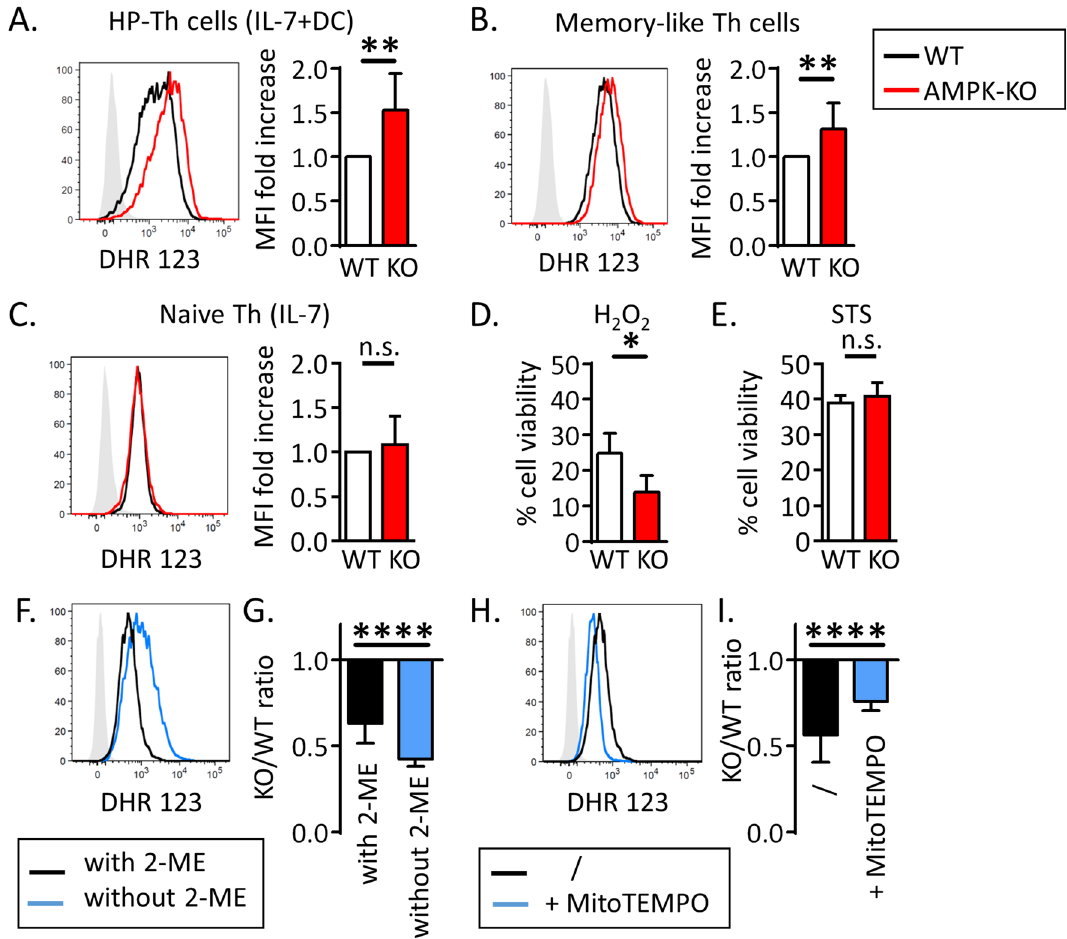
Figure 6. AMPK dampens ROS production and toxicity in T cells. ( A – C ) Cellular ROS staining with DHR123 probe in IL-7 + DC-expanded T cells ( A ), in memory-like Th1 cells ( B ), and in naive T cells ( C ). FACS staining of a representative experiments (left panels) and histogram showing MFI fold increase in AMPK-KO cells in comparison to WT cells set to 1 (right panels). ( D , E ) Percentages of cell viability after treatement of WT and AMPK-KO naive Th cells with H 2 O 2 (0.5 mM for 2 h, D ) or with staurosporine (STS, 5 µM for 4 h, E ). ( F , H ) Cellular ROS staining of naive Th cells after 4 days in IL-7-supplemented culture medium with or without 2-ME ( F ) and supplemented with MitoTEMPO ( H ). ( G , I ) Relative recovery of AMPK-KO T cells after 14 days of homeostatic proliferation in vitro in a culture medium with or without 2-ME ( G ) and with or without MitoTEMPO ( I ). Data are pooled from 7 (n = 11, A ), 9 (n = 8, B ), (n = 7, C ), 3 (n = 5, D ), 4 (n = 4, E ), 4 (n = 20, G ) or 6 (n = 13, I ) independent experiments or are representative of 3 individal experiments ( F , H ). Statistical analysis: Wilcoxon ( A-C ), Mann–Whitney ( D , E , G , I ). *p < 0.05; **p < 0.01; ****p <